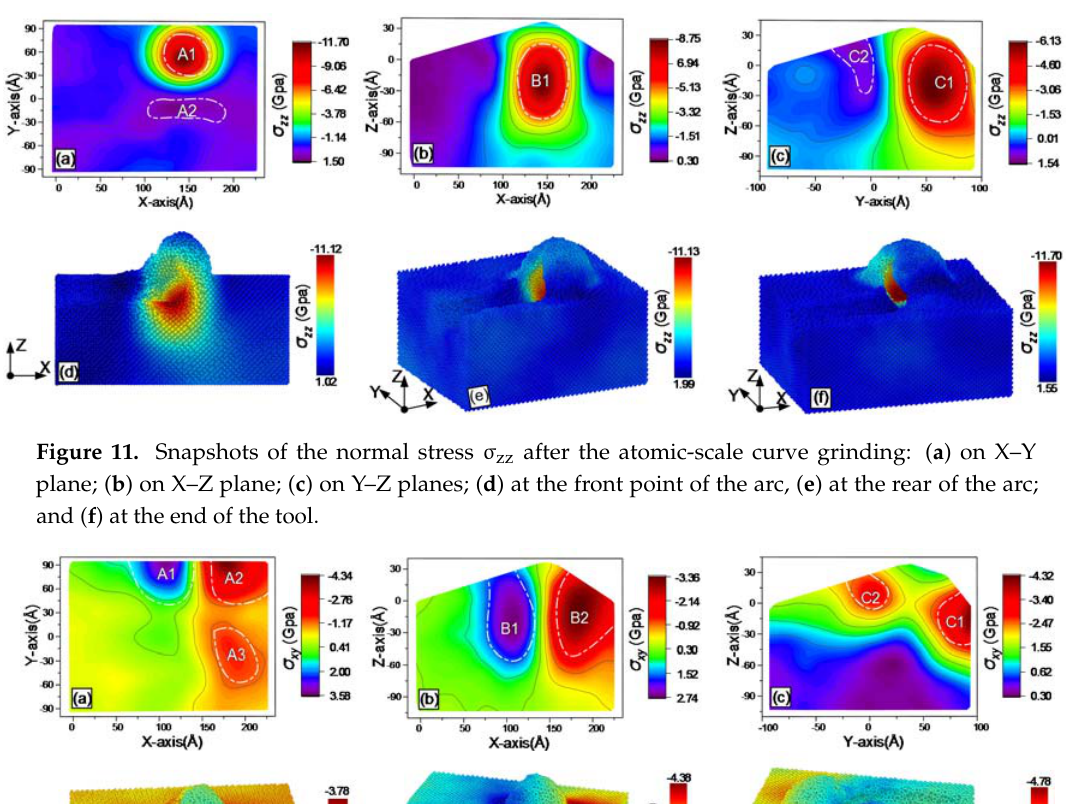
Figure 10. Snapshots of the normal stress σ yy after the atomic ‐ scale curve grinding: ( a ) on X–Y plane; ( b ) on X–Z plane; ( c ) on Y–Z planes; ( d ) at the front point of the arc, ( e ) at the rear of the arc; and ( f ) at the end of the tool.